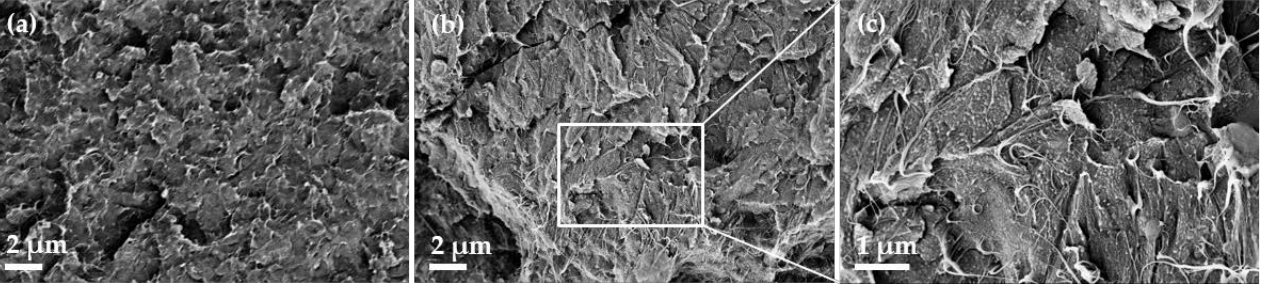
Figure 6. SEM image of PBT composites with 2 wt% SWCNT ( a ) [18] and PBT with 2 wt% SWCNT + 10 wt% PVP ( b , c ).